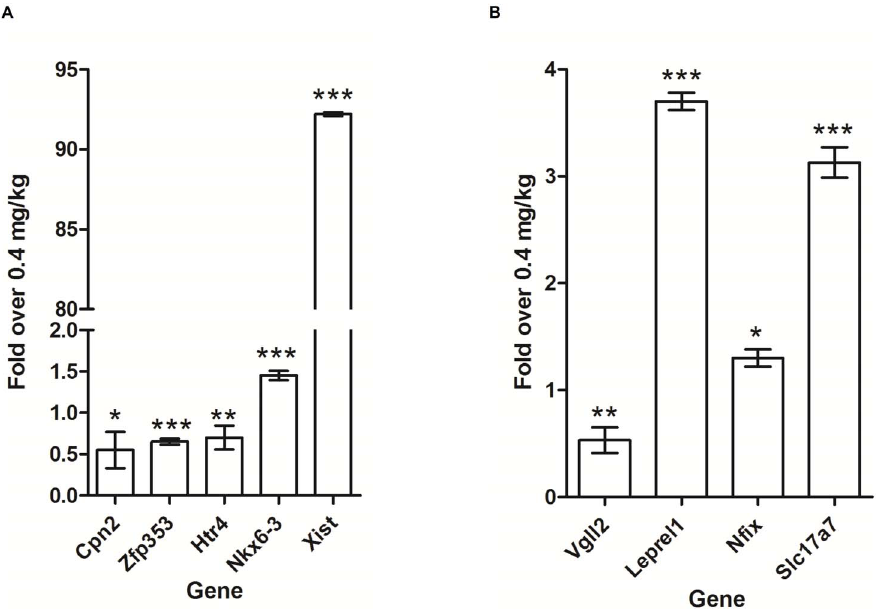
Figure 2. A : Quantitative RT-PCR confirmation of microarray data . Relative expression of the Cpn2 , Zfp353 , Htr4 , Nkx6-3 and Xist transcripts in the cerebral hemispheres of male newborn pups, from mothers supplemented with FA at 4 mg/kg of diet. The results were normalized to Hprt transcript expression, and expressed as relative values in comparison to corresponding transcripts from newborn pups with FA at 0.4 mg/kg diet. Results represent means 6 S.D; asterisks denote statistically significant change (*** P , 0.001, ** P , 0.01 and * P , 0.05). B ): Quantitative RT PCR confirmation of microarray data . Relative expression of the Vgll2 , Leprel1 , Nfix and Slc17a7 transcripts from the cerebral hemispheres of female newborn pups, from mothers supplemented with FA at 4 mg/kg of diet. The results were normalized to Gapdh transcript expression, and were expressed as relative values in comparison to corresponding transcripts from newborn pups with FA at 0.4 mg/kg diet. Results represent means 6 S.D; asterisks denote statistically significant change (*** P , 0.001, ** P , 0.01 and * P ,